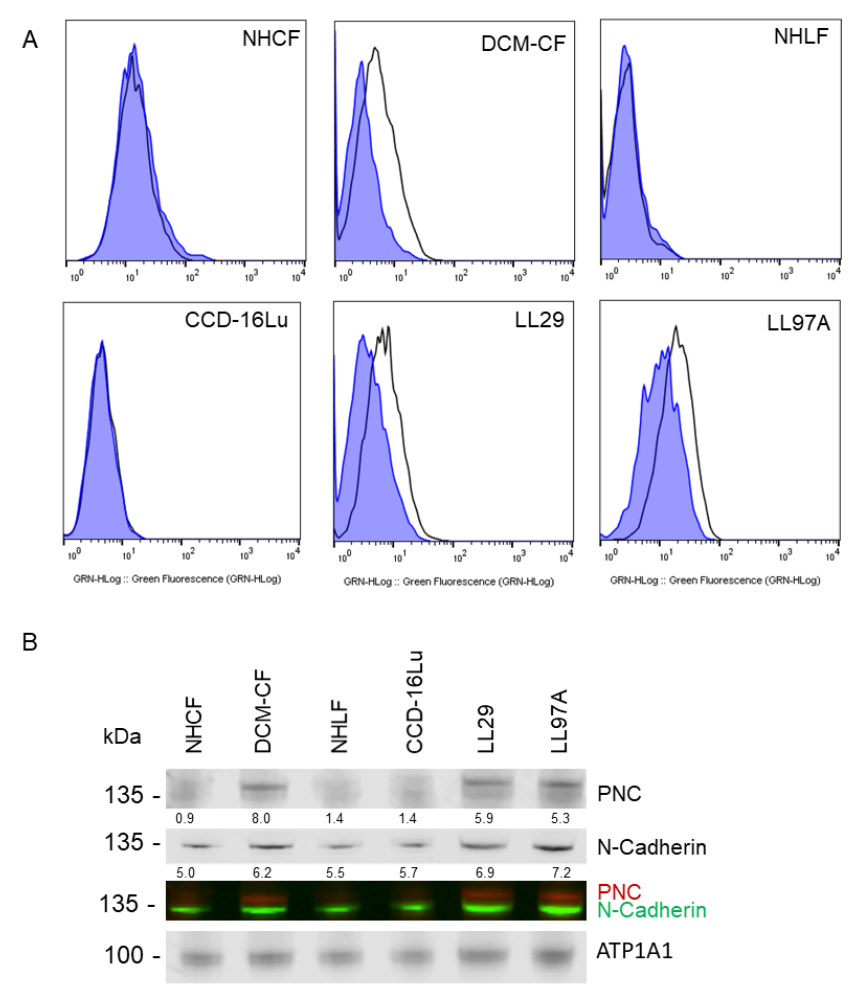
Figure 2. PNC is localized to the cell surface of myofibroblasts. Myofibroblasts from heart and lung tissues were stained and analyzed by flow cytometry using m- α -PNC mAb 10A10, excluding debris and dead cells via gating and 7AAD exclusion using Flowjo software. Myofibroblasts from fibrosis origins stain positive for cell surface PNC: ( A ) CF-DCM, cardiac myofibroblasts from dilated cardiomyopathy; Chi-Squared = 177.5; SE Dymax % Positive = 48.0. LL97A, IPF; Chi-Squared = 93.4; SE Dymax % Positive = 54.8, and LL29, IPF; Chi-Squared = 113.5; SE Dymax % Positive = 51.0. PNC was not detected on the surface of primary normal human cardiac myofibroblasts from healthy donor, NHCF; Chi-Squared = 3.47; SE Dymax % Positive = 8.54, primary normal human lung myofibroblasts from healthy donor, NHLF; Chi-Squared = 0; SE Dymax % Positive = 0, or immortalized CCD-16Lu lung myofibroblasts from healthy donor; Chi-Squared = 0; SE Dymax % Positive = 0. Mouse IgG1 isotype control (blue shaded) was compared to m- α -PNC mAb (unshaded). Results are representative of 3 independent experiments, n = 3. For all flow cytometry experiments, Chi-squared ≥ 4 is statistically significant. ( B ) Cell surface proteins were isolated from myofibroblasts and immunoblotted for N-cadherin, PNC, and Na,k-ATPase α -1 (ATP1A1) cell surface compartment loading control. PNC and N-Cadherin lysates were normalized to the ATP1A1 cell surface loading control for each sample and are reported as a relative value below each band.